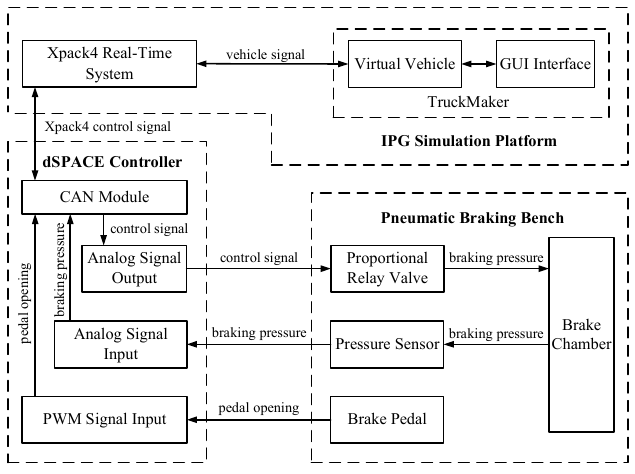
Figure 2. Verification system structure.